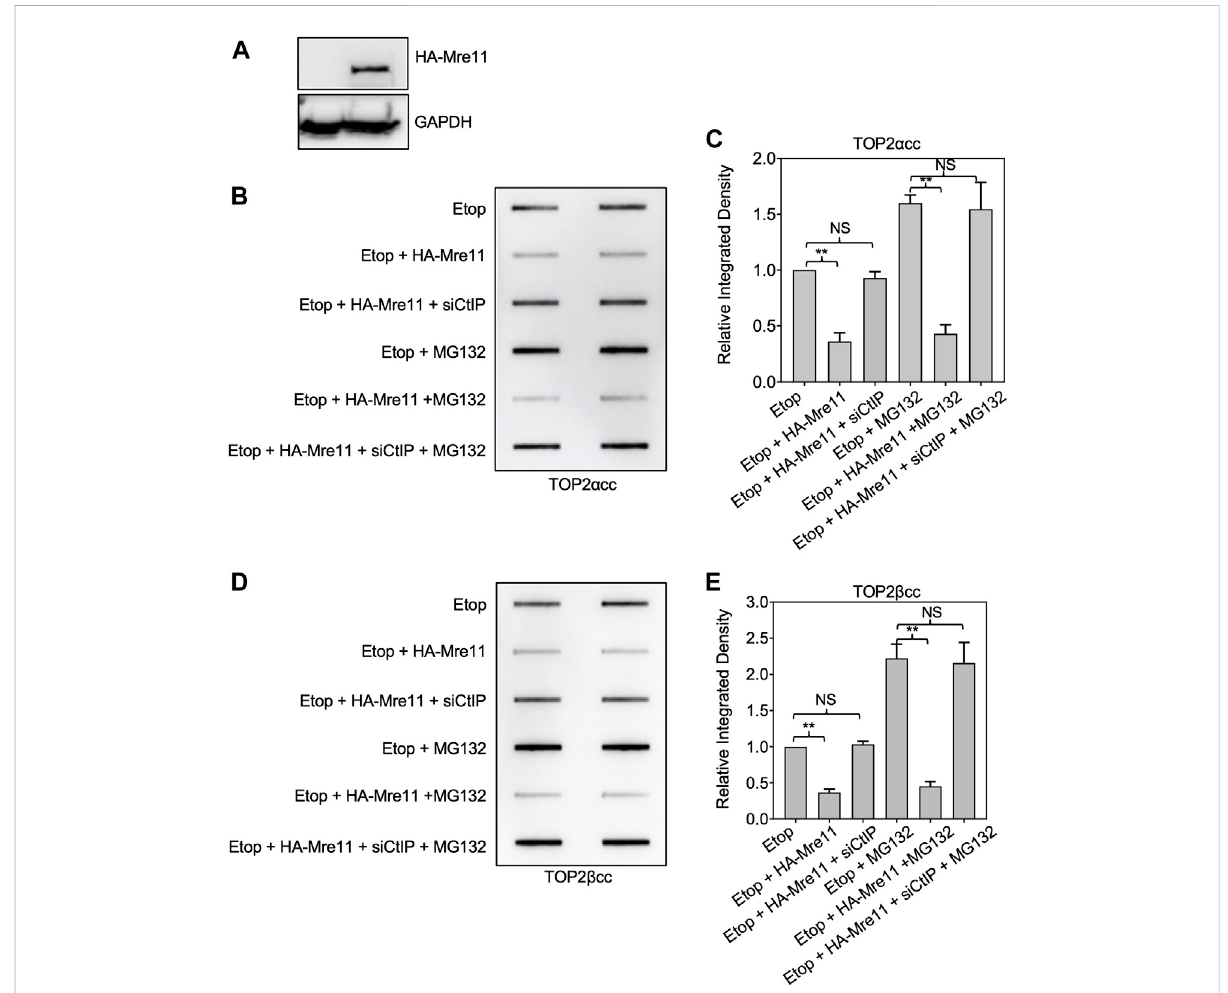
Ectopic expression of MRE11 results in removal of TOP2ccs in cells treated with proteasome inhibitors. HEK293 cells were transfected with indicatedplasmidandorsiRNAfor48 hpriortotreatmentwith10 μ MMG132for1 h.Etoposide(10 μ